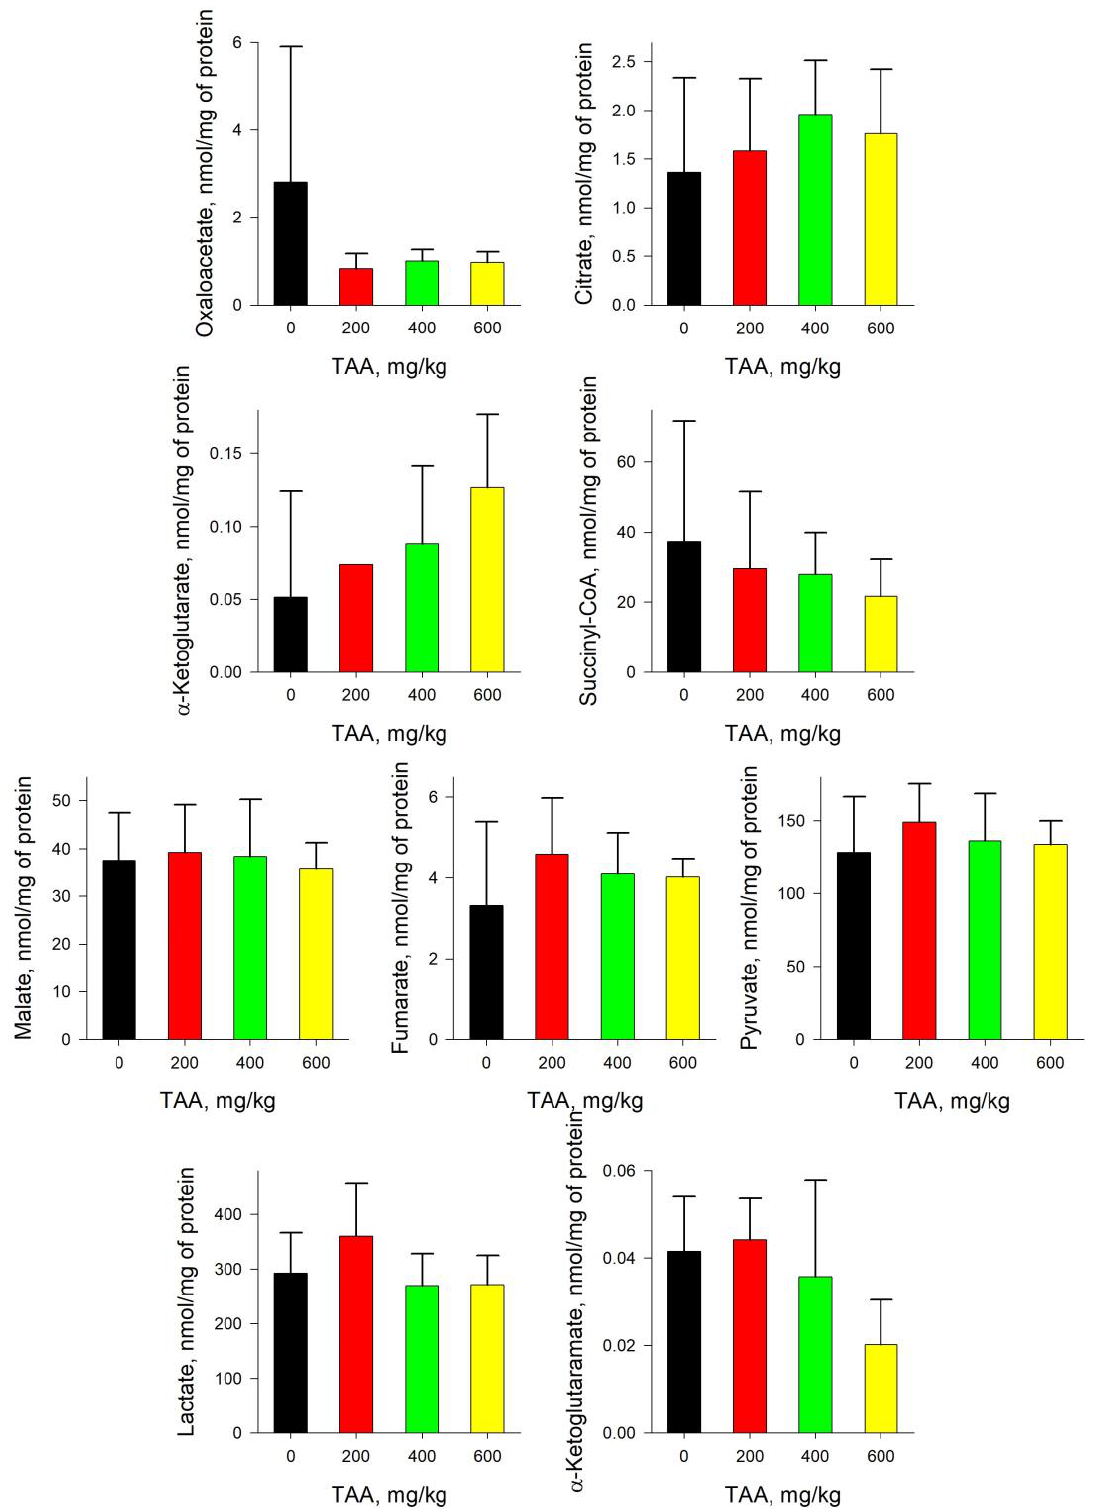
Figure 7. Concentration of TCA cycle and associated metabolites in the brain tissue of control and TAA-treated rats (AVG ± STDEV, nmol/mg of protein). According to results obtained by Tukey’s test, all data were not significantly different.